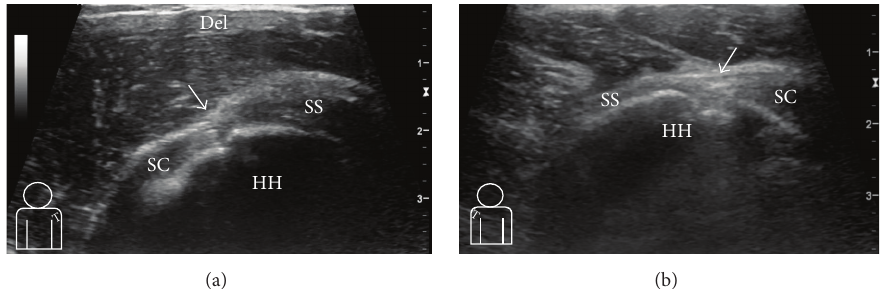
Figure 1: Ultrasound (US) images of both shoulders. (a) US parasagittal image of the left shoulder rotator interval. The long head of the biceps tendon is not identifiable in its normal position (white arrow). (b) US parasagittal image of the right shoulder rotator interval. The long head of the biceps tendon is not discernible in its normal position (white arrow). HH = humeral head; SS = supraspinatus tendon; SC = subscapularis tendon; Del = deltoid muscle.